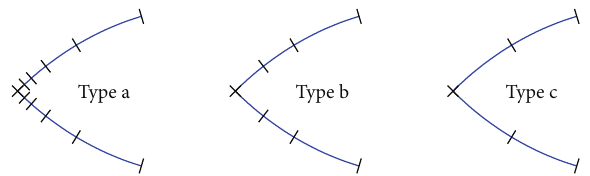
Figure 19: Meshes of type a, type b, and type c on the boundary = 3 . The type a mesh has 4 + 2𝑖 panels. subset Γ ⋆ 𝑖 for 𝑖 = 3 and 𝑛 sub The type b mesh has six panels. The type c mesh has four panels. The , the type a mesh is the restriction of the fine mesh to Γ ⋆ 𝑖 . For 𝑖 = 𝑛 sub type c mesh is the restriction of the coarse mesh to Γ ⋆ . The type a mesh and the type b mesh coincide for 𝑖 = 1